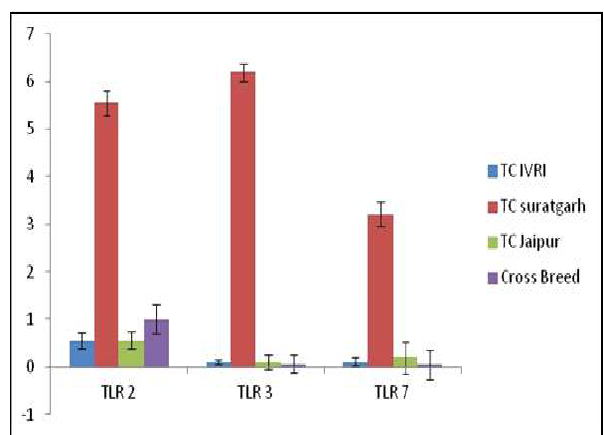
Figure-1: The expression profiles of TLR2, 3 and 7 mRNA by Real-time quantitative PCR in Tharparkar cattle from different regional farms and crossbred cattle